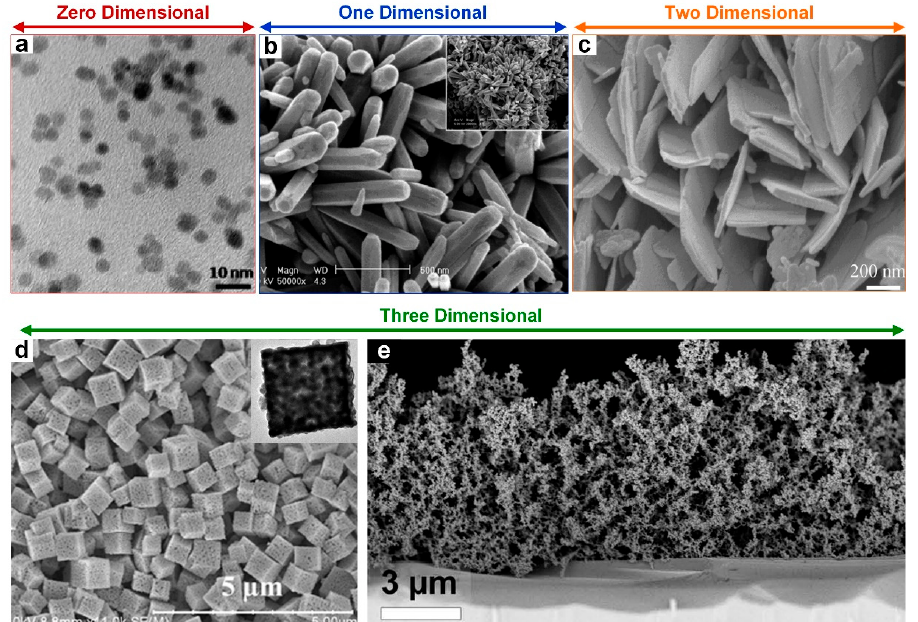
Figure 1. ( a ) Typical TEM image of ZnO QDs obtained through a wet synthesis method based on alkaline-activated hydrolysis and condensation of zinc acetate solutions [27]. ( b ) SEM images of ZnO nanorods bundles synthesized at 150 °C, over 4 hours [28]. ( c ) SEM image of ZnO nano-sheets formed through a simple mixed hydrothermal synthesis method [29]. ( d ) SEM images of acid-washed porous SnO 2 microcubes after calcination at 900 °C for 2 hours. Inset: TEM image of the as-prepared porous SnO 2 microcubes [30]. ( e ) ZnO ultraporous film made by flame spray pyrolysis